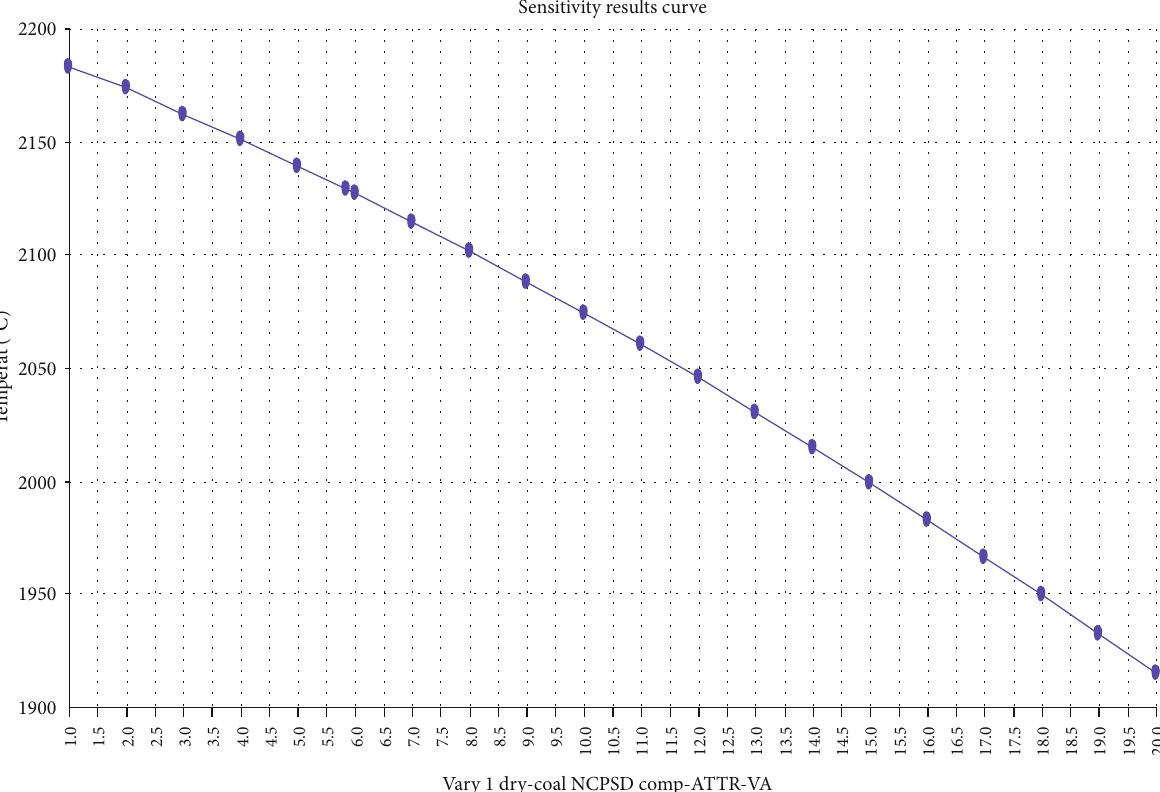
Figure 10: Coal moisture content vs. combustion